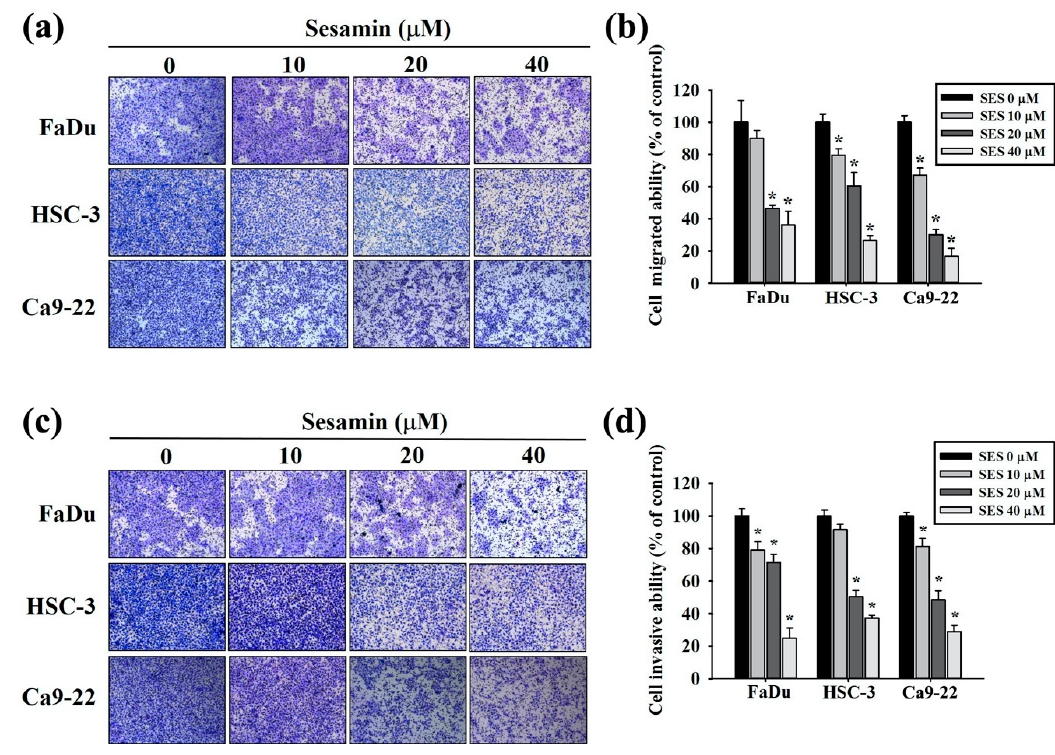
Figure 3. Cell invasion and migration of human oral cancer cells following sesamin treatment. ( a ) FaDu, HSC-3, and Ca9-22 cell lines were treated with SES (0, 10, 20, and 40 μ M) in serum-free medium for 24-h and subjected to transwell assays as described in the “Material and Methods” section. ( b ) Quantitative results for the FaDu, HSC-3, and Ca9-22 cell lines; the numbers of cells that migrated to the underside of the porous polycarbonate. ( c ) FaDu, HSC-3, and Ca9-22 cell lines were treated with SES (0, 10, 20, and 40 μ M); cell invasion was subsequently measured using Matrigel-coated transwell inserts as described in the “Material and Methods” section. ( d ) Quantitative results for the FaDu, HSC-3, and Ca9-22 cell lines; the numbers of cells that invaded the underside of the porous polycarbonate. The values represent the means ± SD of at least three independent experiments. * p < 0.05, compared with the control group.